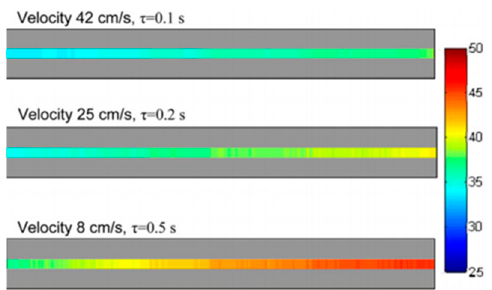
Figure 5. Temperature profiles in a microchannel reactor during the hydrolysis of tetraethoxysilane at different flow velocities and times, from Haber et al. [59]. The scale bar provides the correspondence between colors and temperatures in ◦ C. Reprinted by permission from Ref. [59], Chemical Engineering Journal, Copyright © 2022 Elsevier.